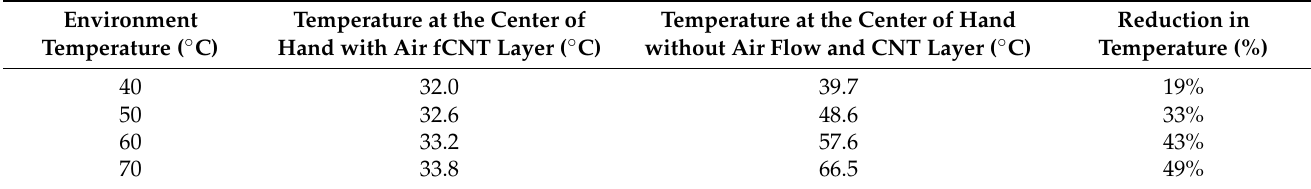
with forced convection heat transfer at 2 m/s air flow. The convection area temperature is 29 °C. Table 1. Comparison between temperature at the center of hand with and without the air flow and CNT layer.